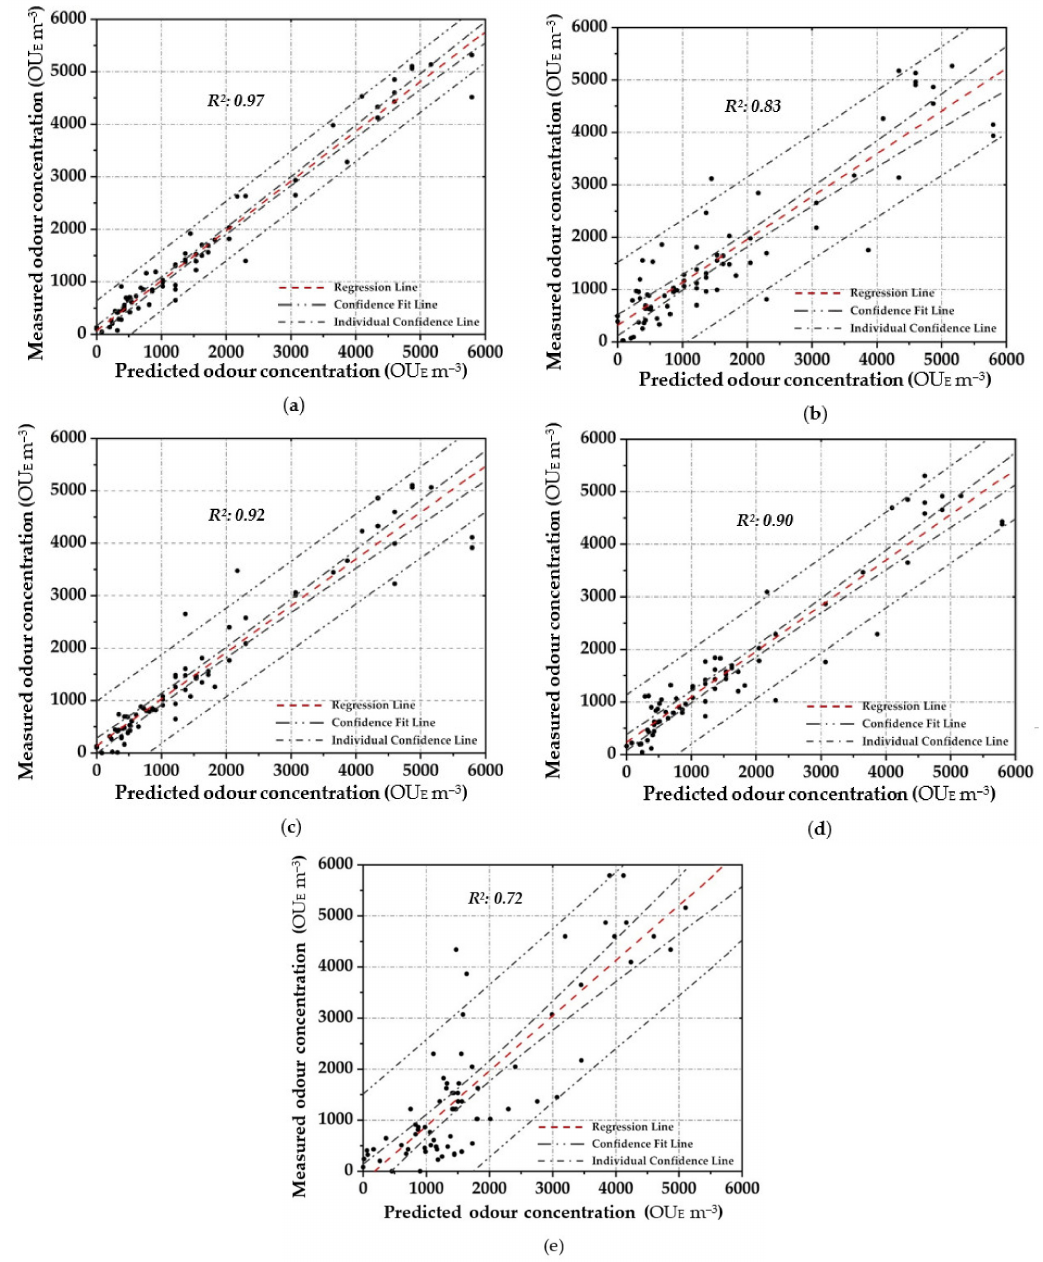
Figure 4. Scatter plot between the measured odour concentration with DO and the predicted one with the elaborated OQMMs using Table 4. (( a )—ANN, ( b )—MARSPline, ( c )—PLS, ( d )—RSR and ( e